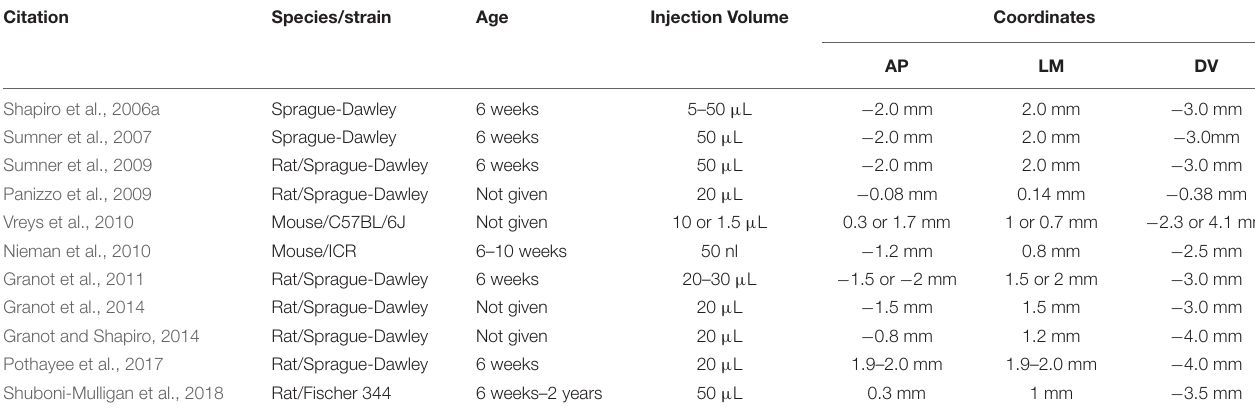
TABLE 1 | In situ NPC labeling